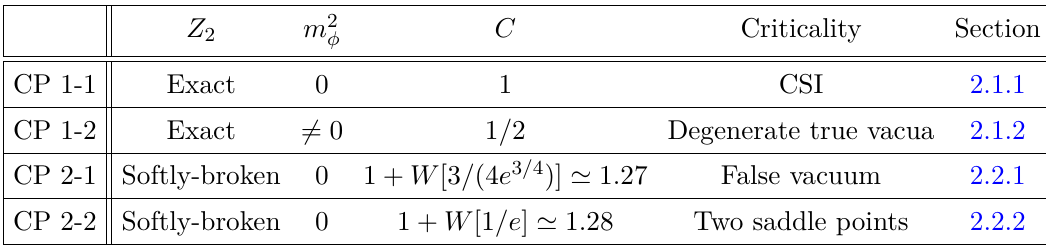
Table 1 . Critical points with the exact Z 0 symmetry (CP 1-1 and CP 1-2) and those with the 2 softly-broken Z 0 symmetry (CP 2-1 and CP 2-2). The factor C appears in the mass formula of H 2 given in eq.